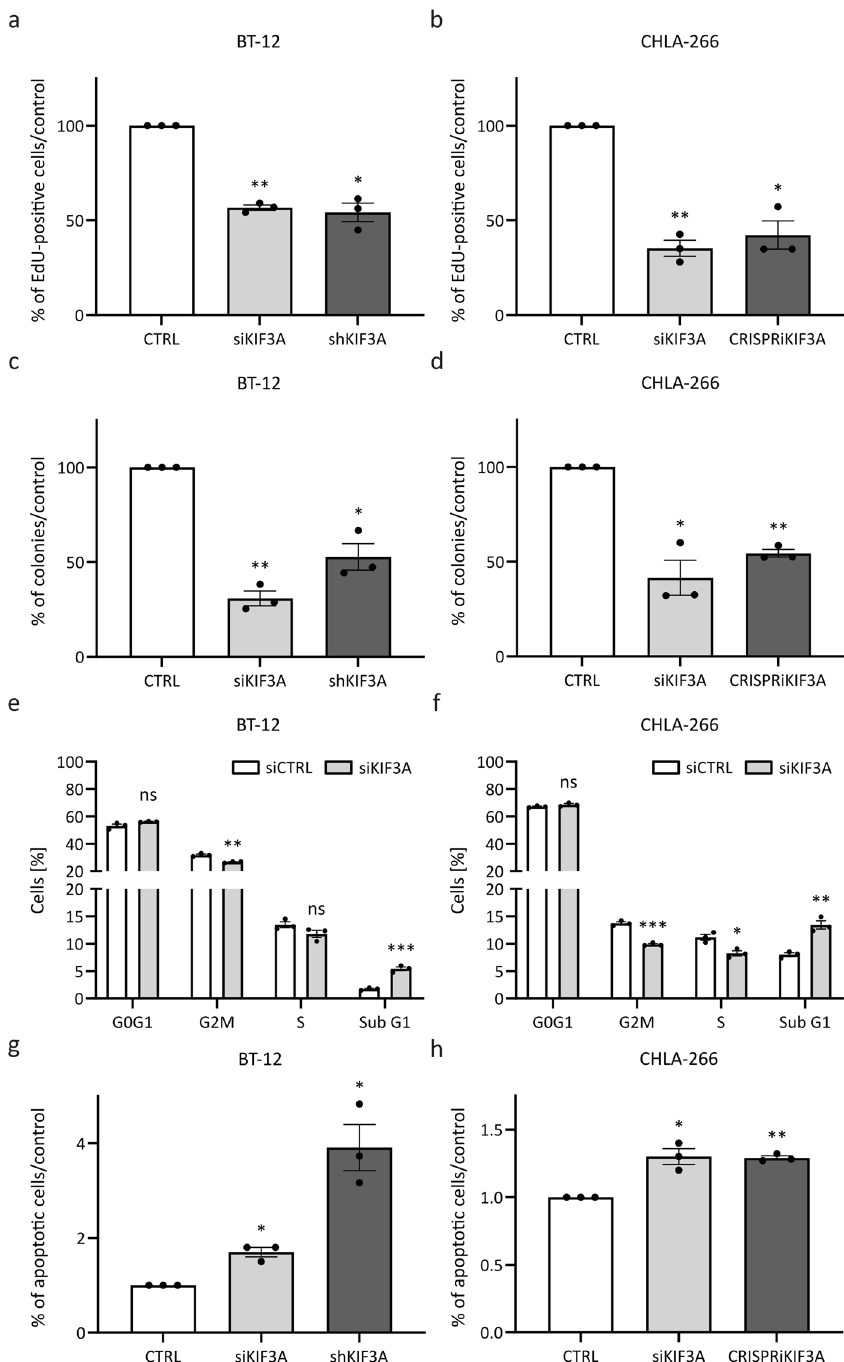
Fig. 2 Knockdown of kinesin family member 3A ( KIF3A ) decreases the oncogenic potential of the AT/RT cell lines BT ‐ 12 and CHLA ‐ 266. Transient knockdown of KIF3A was achieved using siPOOLs. Stable knockdown of KIF3A was achieved using shRNA ‐ based (BT ‐ 12) or CRISPRi ‐ based (CHLA ‐ 266) technology. a , b Transiently or stably transfected BT ‐ 12 ( a ) and CHLA ‐ 266 ( b ) cells were incubated with 10 μ M EdU (modi fi ed thymidine analogue) for 6 h. Cells were fi xed and EdU was detected using Alexa Fluor ™ 488 azide. Cells were counterstained with 4´,6 ‐ diamidino ‐ 2 phenylindole (DAPI). The percentage of proliferating cells was calculated based on the number of EdU ‐ labeled cells in relation to the number of DAPI ‐ labeled cells. c , d Quanti fi cation of colonies formed by transiently or stably transfected BT ‐ 12 ( c ) and CHLA ‐ 266 ( d ) cells following plating of 100 (BT ‐ 12) or 500 (CHLA ‐ 266) cells per 10 cm dish and 17 (BT ‐ 12) or 24 (CHLA-266) days of incubation. e , f Cell cycle pro fi les of transiently transfected BT ‐ 12 ( e ) and CHLA ‐ 266 ( f ) cells. Cells were fi xed and stained with propidium iodide (PI). DNA content was analyzed using fl ow cytometry. g , h To assess cells undergoing apoptosis, cells were stained with annexin V and PI and analyzed using fl ow cytometry. Shown are bar graphs representing the fold change in apoptotic cells following transient or stable KIF3A knockdown in the AT/RT cell lines BT-12 ( g ) and CHLA ‐ 266 ( h ). Values shown represent mean ± SEM of three biologically independent replicates. ns: not signi fi cant, * p < 0.05; ** p < 0.01; *** p < 0.001 ( t -test).